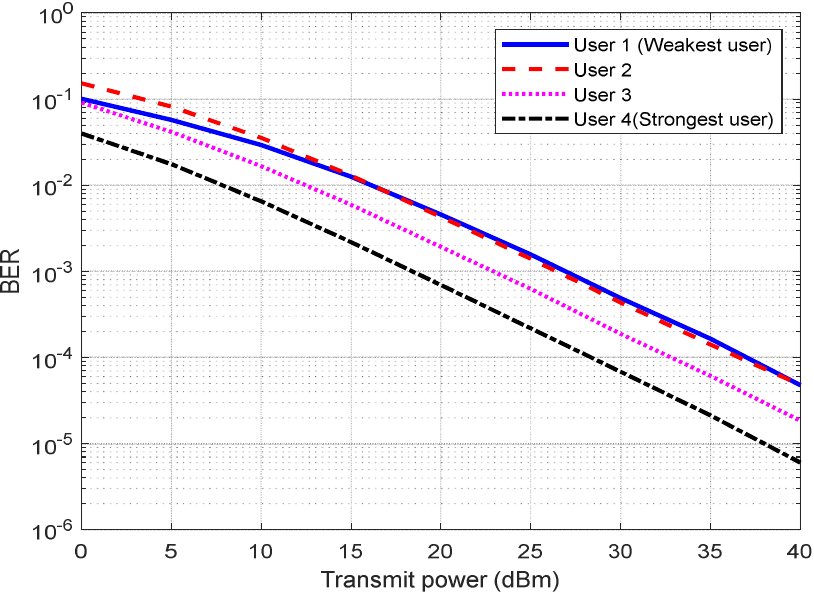
Figure 5. BER vs. transmitting power for four users with varying distances and power coefficients, for DL NOMA at BW (80 MHz with 64 × 64 MIMO for DL NOMA.